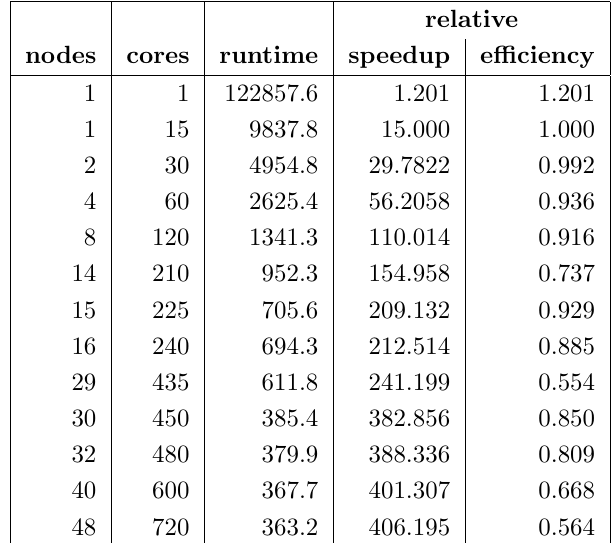
Table 1 . Timings and e(cid:14)ciency for the cut f 1 ; 3 ; 4 ; 5 g . We use the same algorithm for all core counts. The single core run serves as a